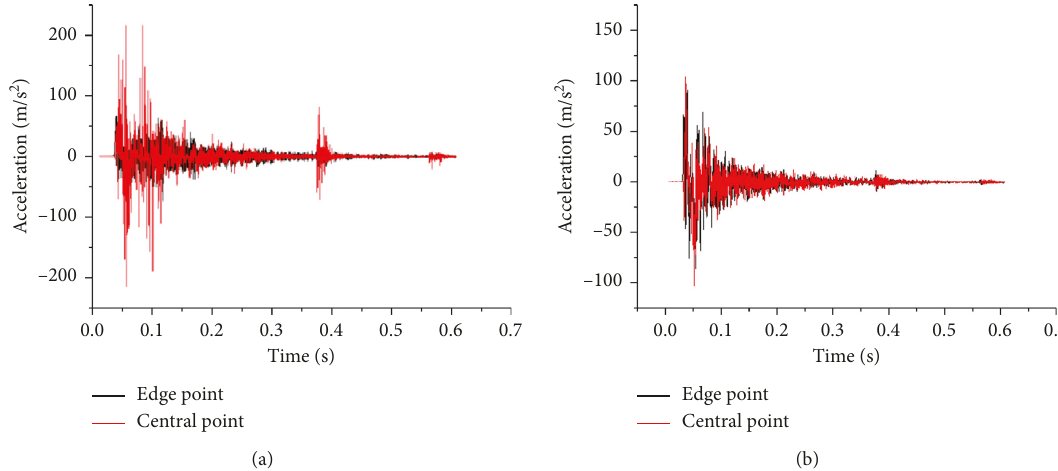
Figure 7: Acceleration curves of edge point and central point under working condition 1. (a) Bottom plate. (b) Upside